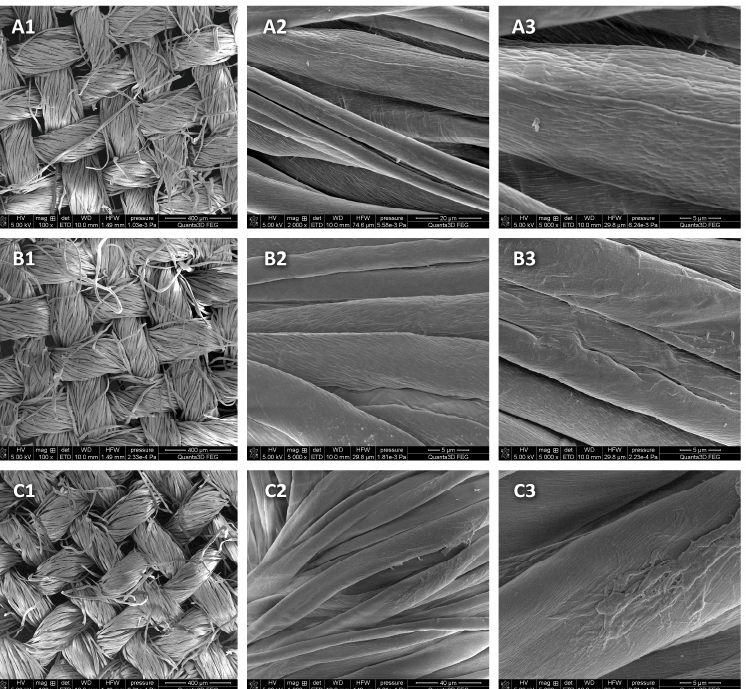
Figure 4. SEM micrograph showing the topographies and surface morphologies of the samples: ( A1 – A3 ) model co tt on—control; ( B1 – B3 ) model co tt on—after the application of 90% ethanol in the form of mist and direct drying; ( C1 – C3 ) model co tt on—after the application of 90% ethanol in the form of mist and drying after 22 h of storage in ethanol vapor. Enlargements: (1) 100×, (2) 500× and (3) 5000×